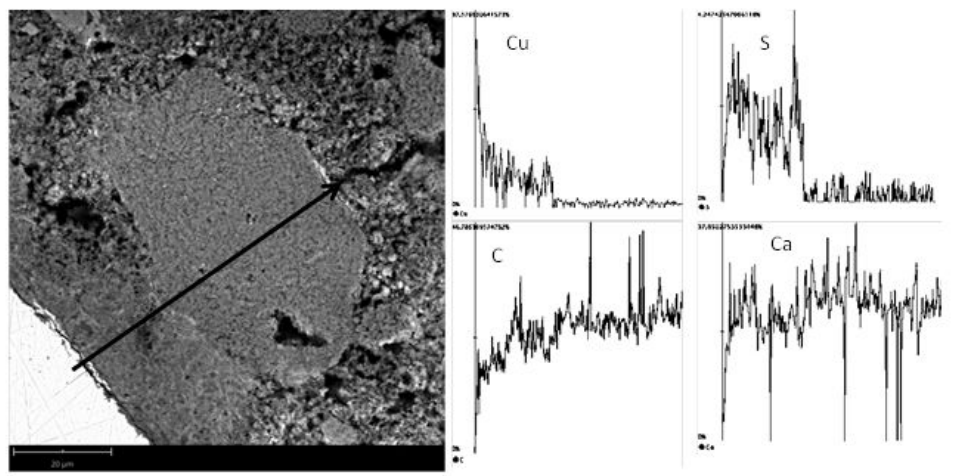
Figure 4. Detail of copper – lime interface. The arrow indicate line scan.